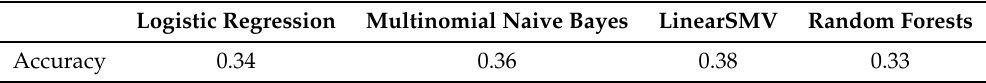
Table 3. Accuracy of classification algorithms.